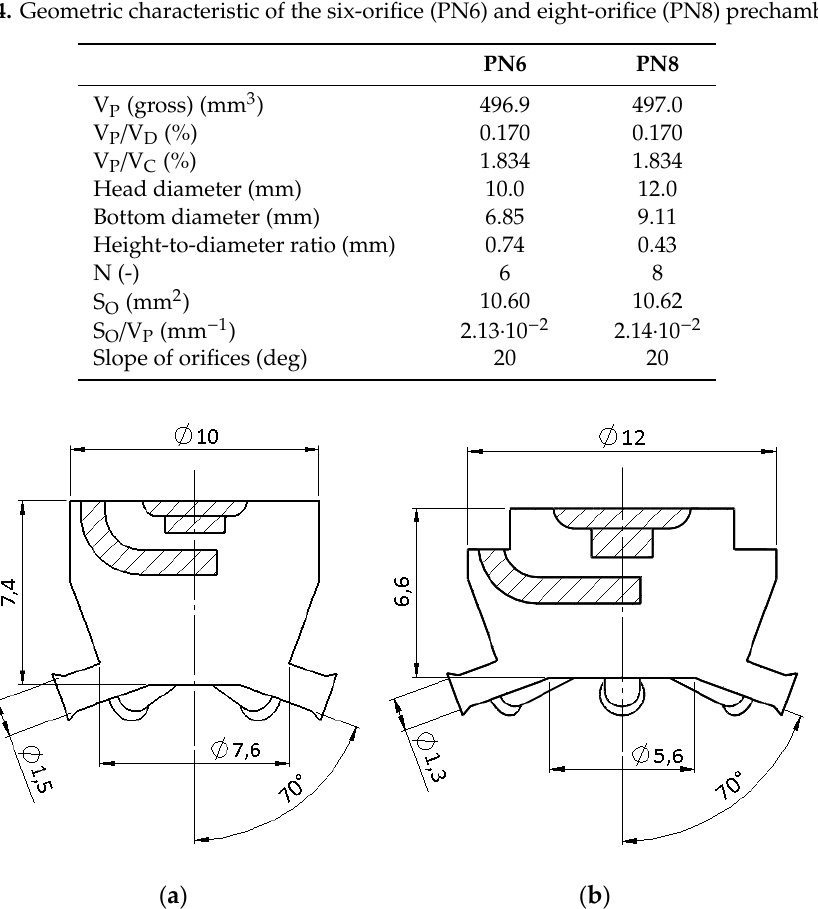
Table 4. Geometric characteristic of the six-orifice (PN6) and eight-orifice (PN8) prechambers.